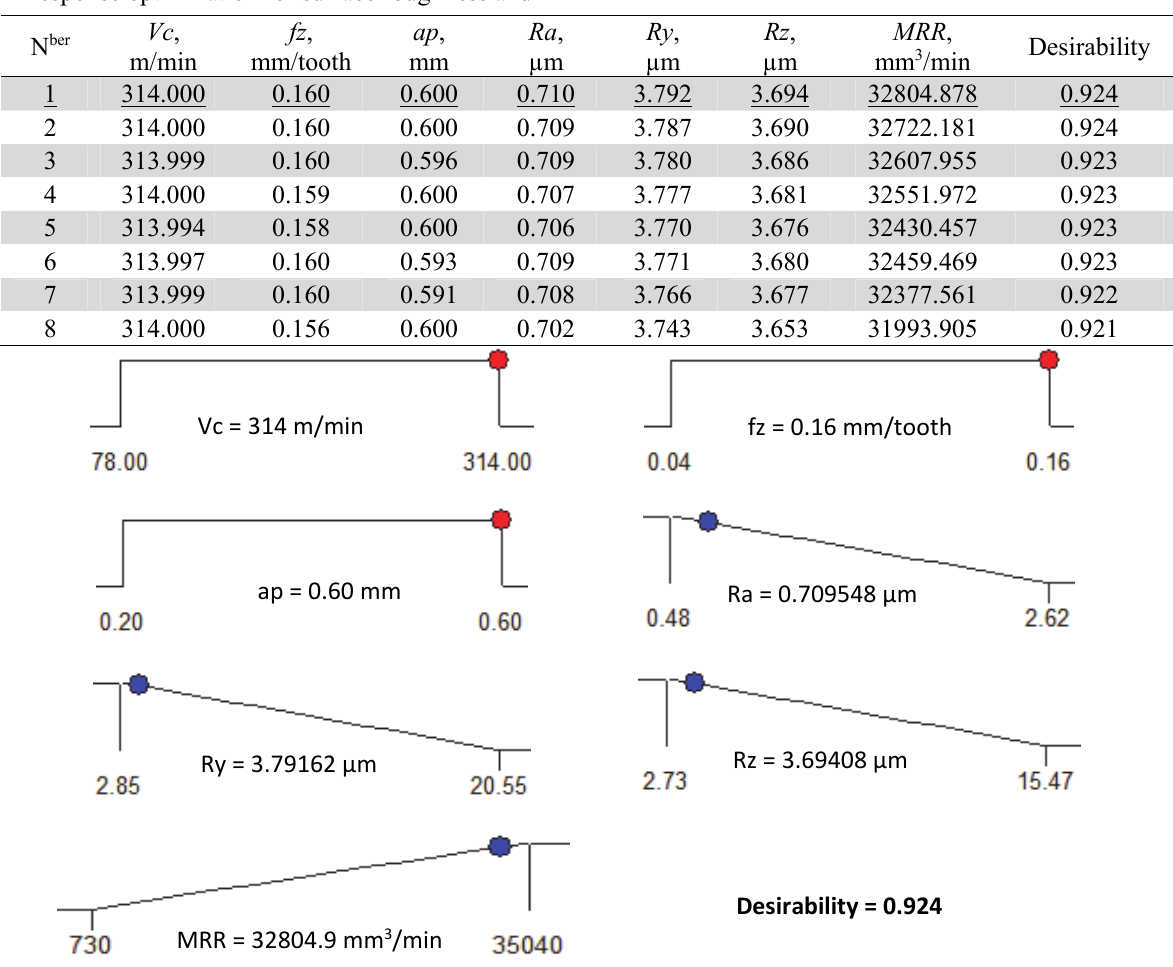
Response optimization for surface roughness and MRR